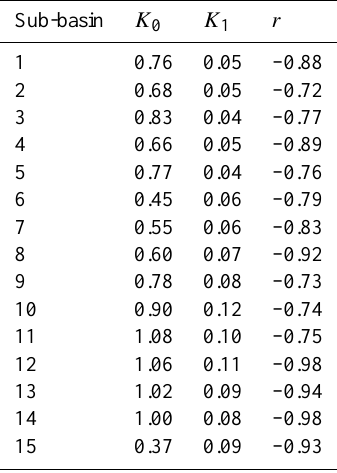
Table 2. Values of parameters K 0 and K 1 of Eq. (3) and the linear correlation coefficients r between h CV Q1h i CL and log ( h AR i CL ) in each sub-basin.